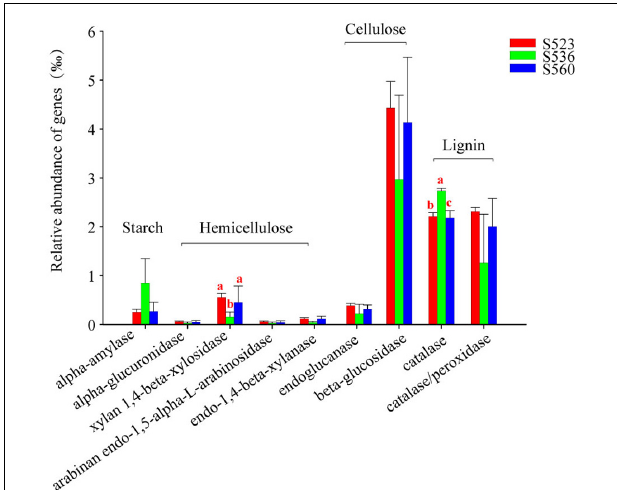
FIGURE 7 | The relative abundance of functional genes associated with litter degradation within the litter bacterial community over different phytoremediation years. PICRUSt was used to predict bacteria species associated with litter degradation. Alpha-amylase was related to starch decomposition as well as other active substances. The enzymes endo-1,4-beta-xylanase, arabinan endo-1,5-alpha-L-arabinosidase, alpha-glucuronidase and xylan 1,4-beta-xylosidasewere related to hemicellulose decomposition. Endoglucanase and beta-glucosidase were involved in cellulose decomposition, and catalase/peroxidase was the main lignin-modifying enzymes. Different letters denote significant differences over different phytoremediation years ( P <